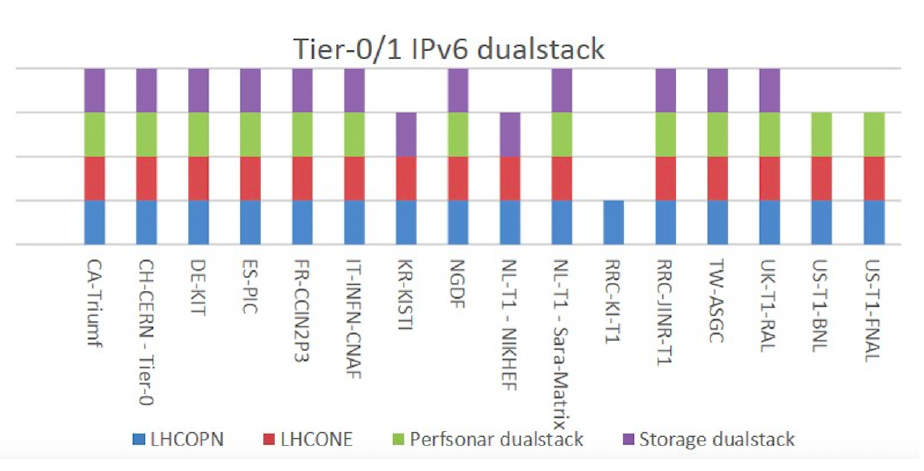
Figure 1. IPv6 tra ffi c through the CERN central firewall, period Oct 2017 to Sep 2018